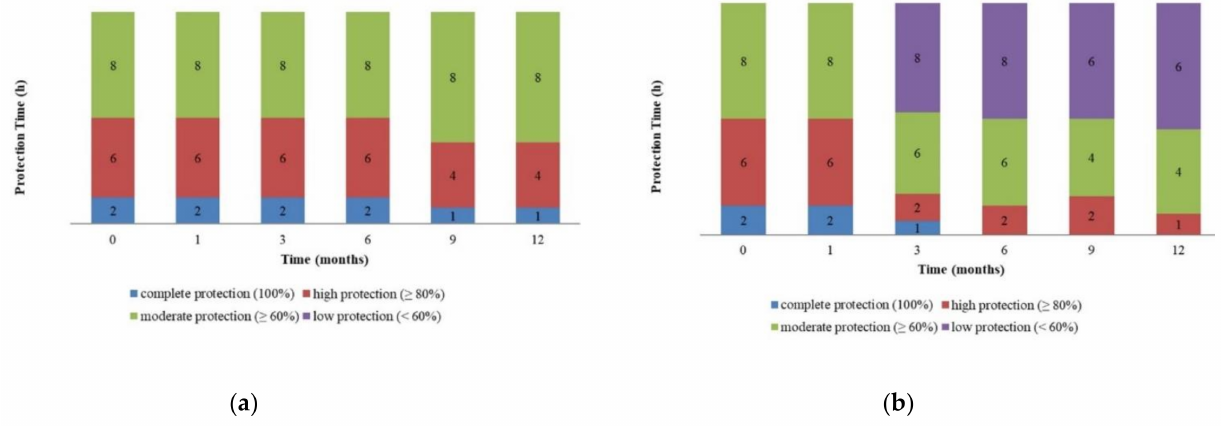
Figure 4. Repellent effects. ( a ) Microencapsulated formulation; ( b ) non-encapsulated formulation. Stored at 25 ± 2 ◦ C/60% ± 5% RH and 40 ± 2 ◦ C/75% ± 5%